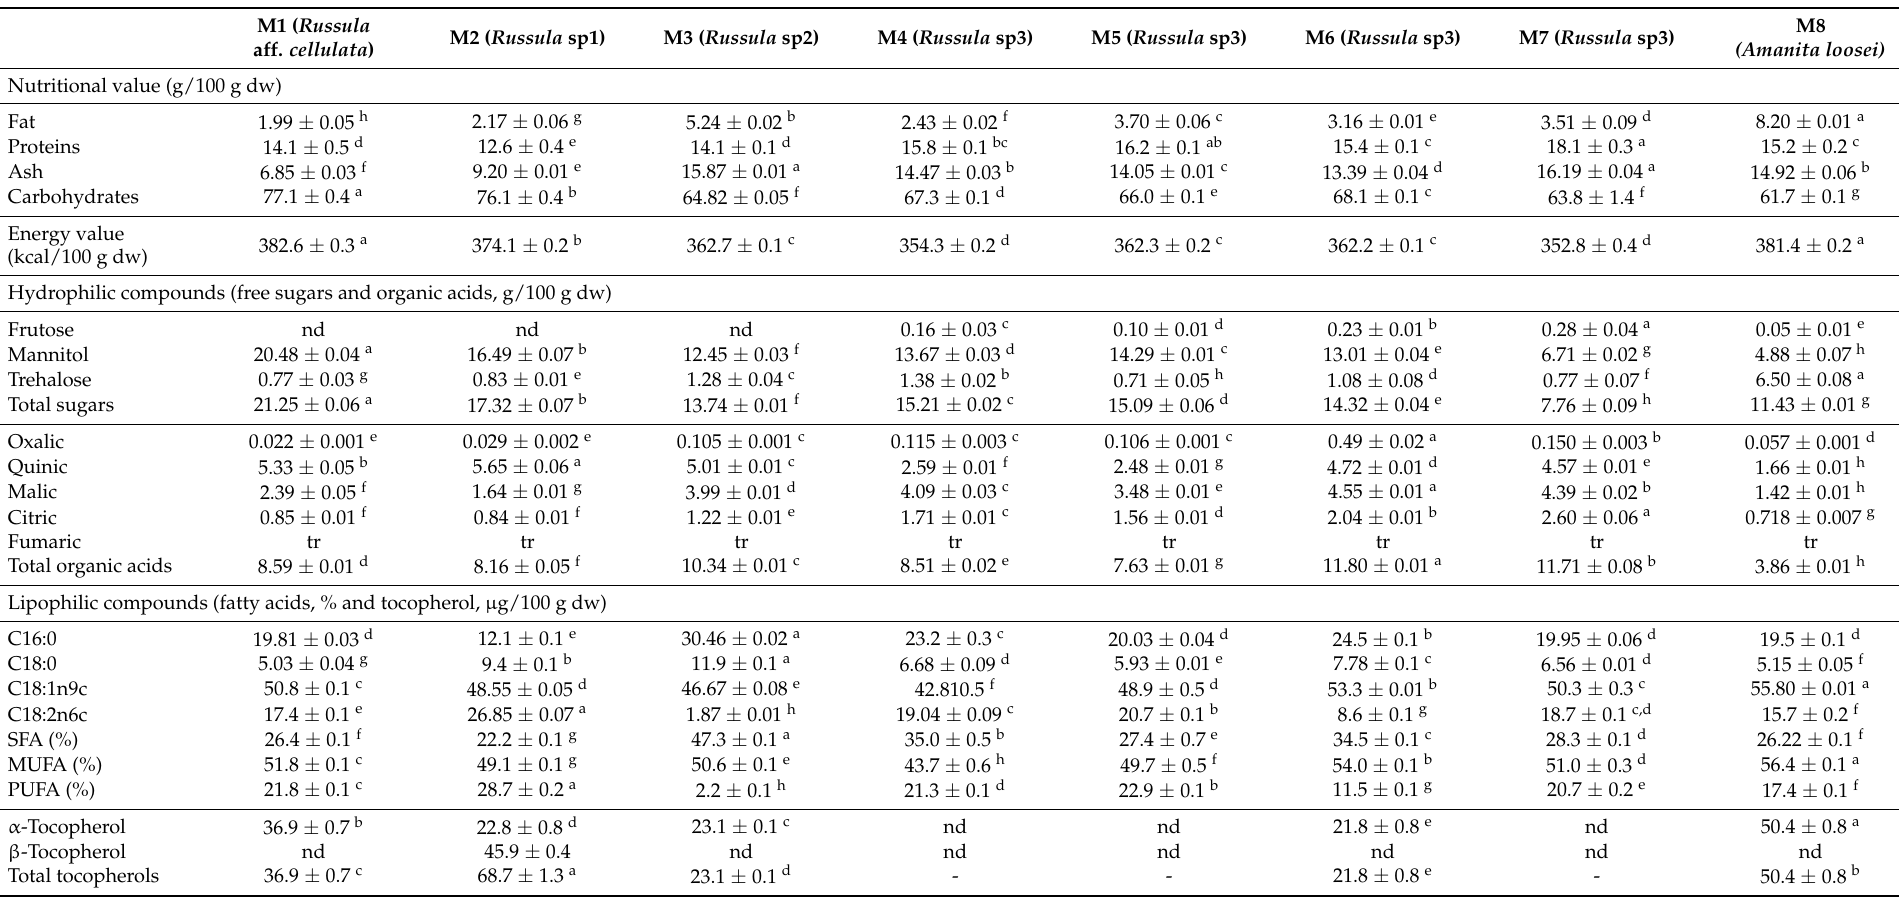
Table 2. Nutritional, hydrophilic, and lipophilic compounds of the studied mushrooms’ samples from Huila, Angola (mean ± SD, n =